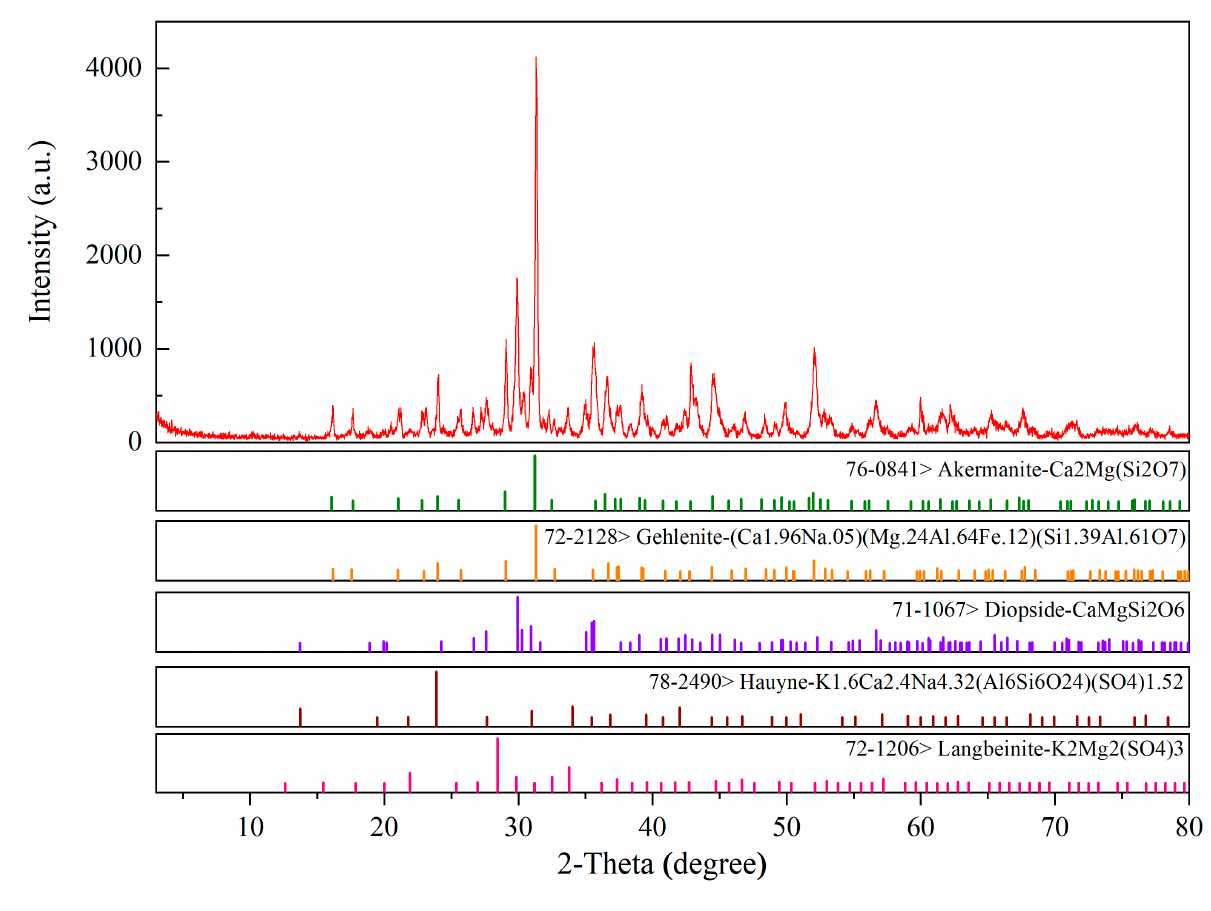
Figure 1. The XRD analysis results of the ceramsite. Table 1. Chemical composition of ceramsite samples (excluding